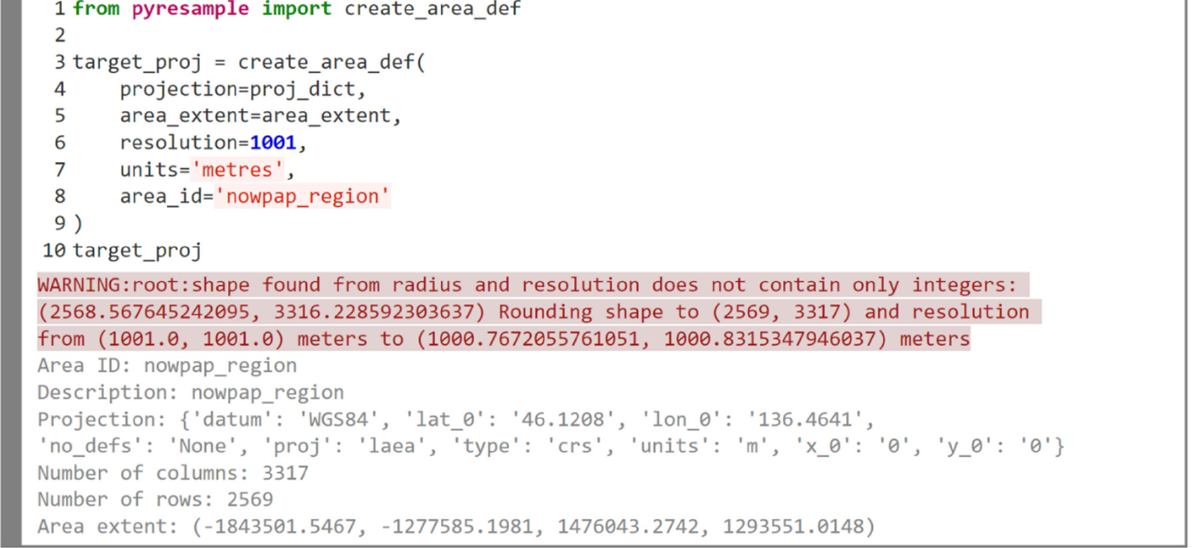
Figure A4. Python code snippet of Pyresample area definition for the target projection. The area definition is used in step 1 of swath reprojection.